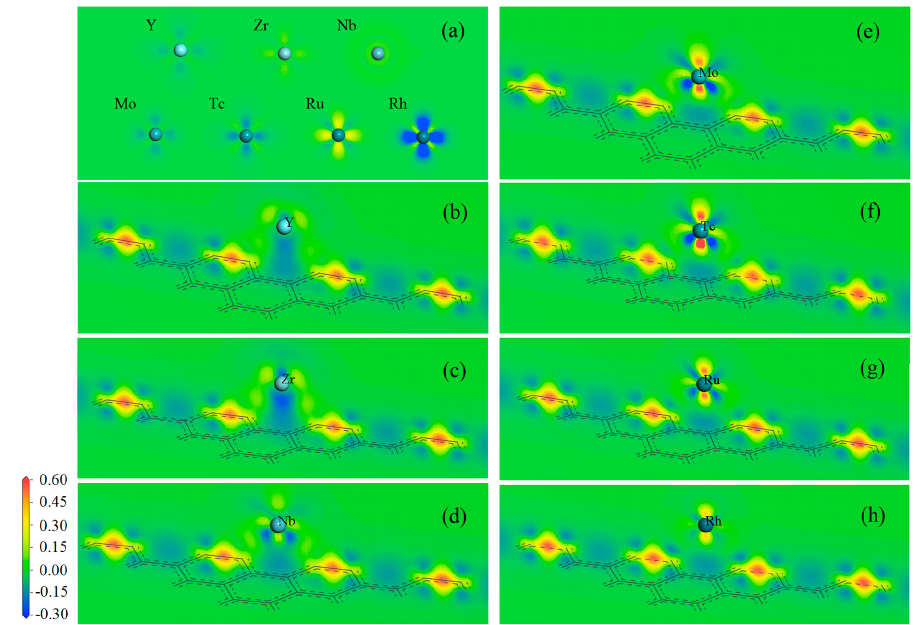
Figure 2. Electron density differences of ( a ) isolated 4 d -transition atoms and ( b – h ) Y, Zr, Nb, Mo, Tc, Ru and Rh/graphene C-site adsorptions, contoured on the plane vertical to the graphene sheet and crossing the absorbed atom.